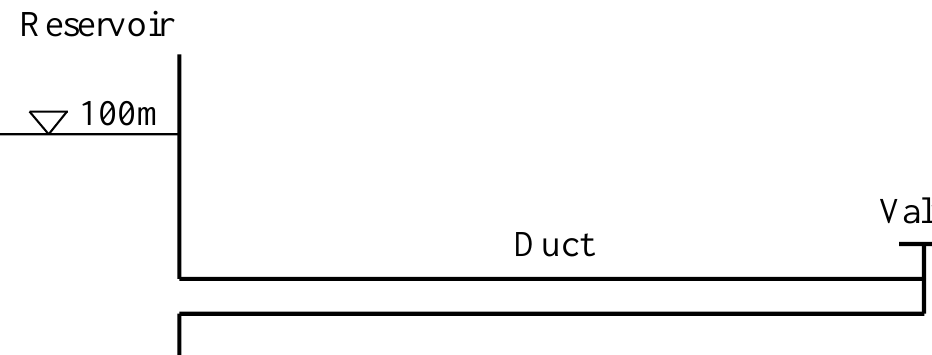
Figure 2. Schematic geometry of the RDVS.